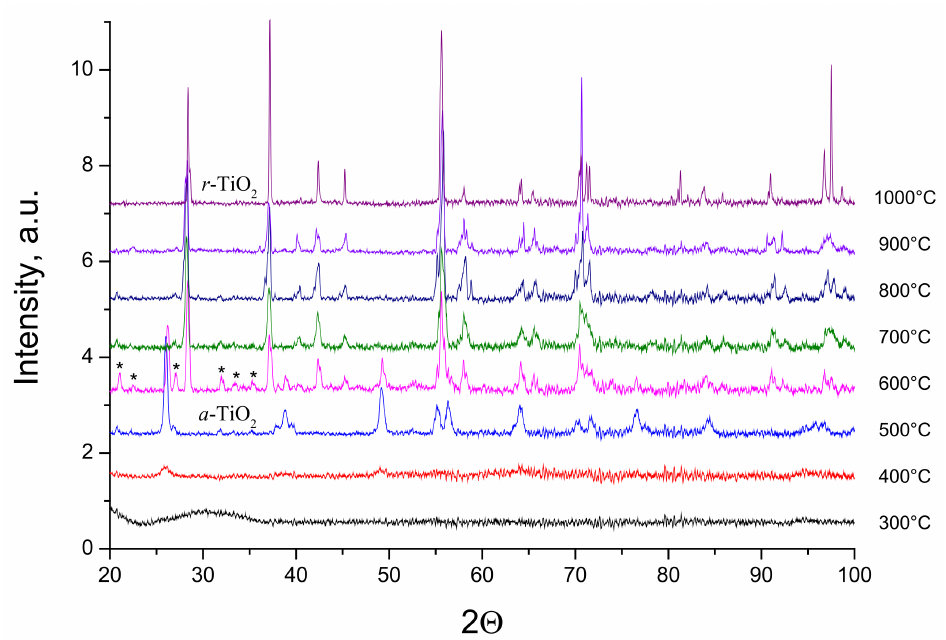
Figure 4. XRD powder patterns of V-TiO 2 samples with 20 mol% vanadium content heat treated at different temperatures for 4 h. Anatase ( a ) and rutile ( r ) phases of TiO 2 are indicated. Peaks assigned to α -V 2 O 5 orthorhombic phase are labeled by